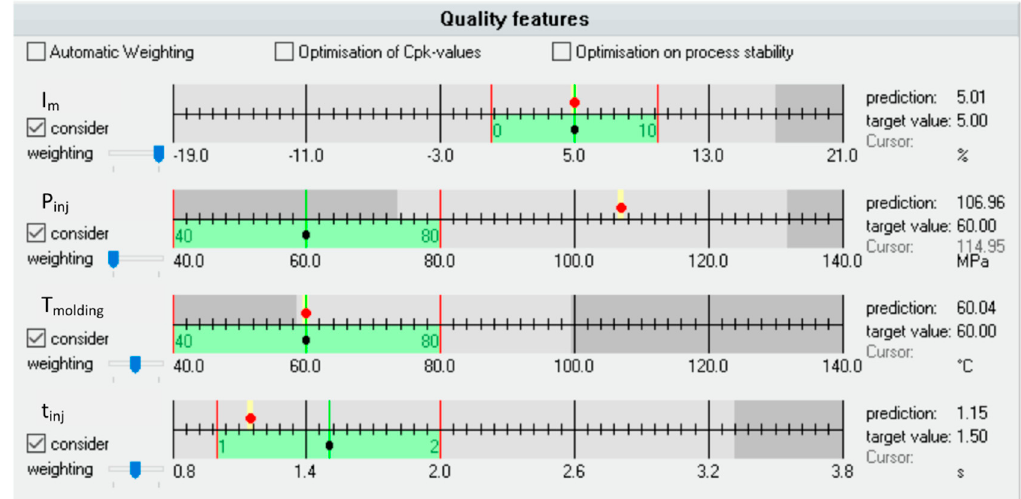
Figure 11. Optimization criteria for optimal setting with respect to predefined range: ( a ) I m —imbalance ( b ) P inj —injection pressure, ( c ) T molding —molding temperature, ( d ) t inj —injection time.